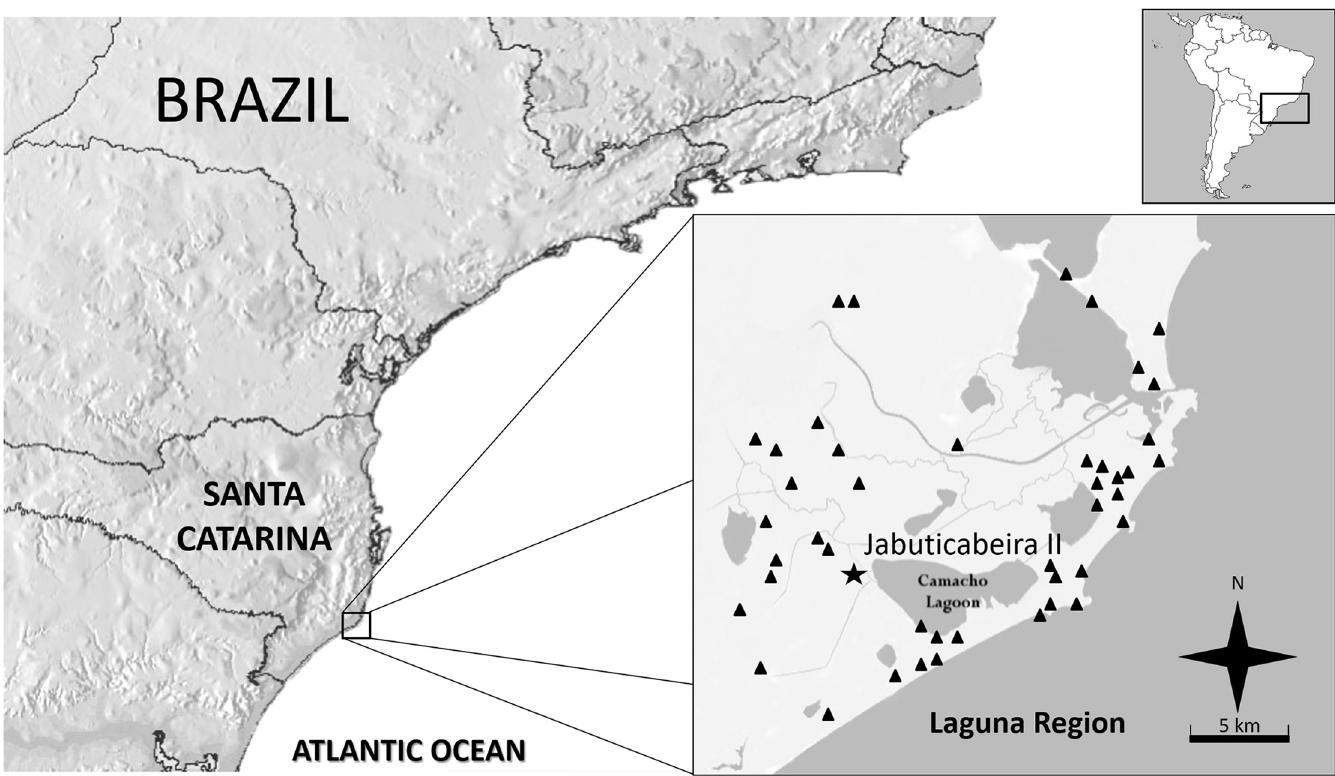
Fig 1. Setting of Jabuticabeira II. The star represents Jabuticabeira II, the triangles represent other sambaquis mapped for the Laguna Region (modified from Boyadjian et al. [31:137]).